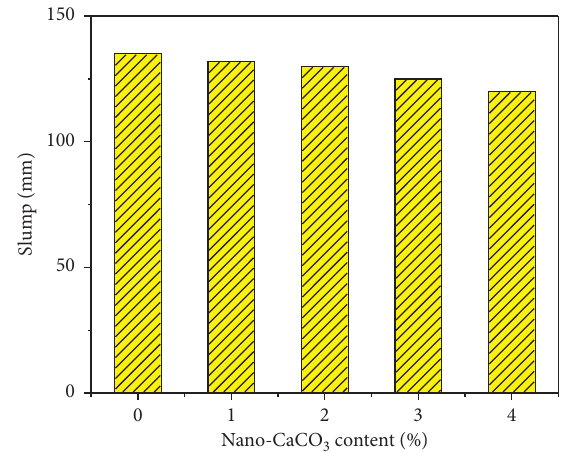
Figure 5: Relationship between the slump and NC content [62].